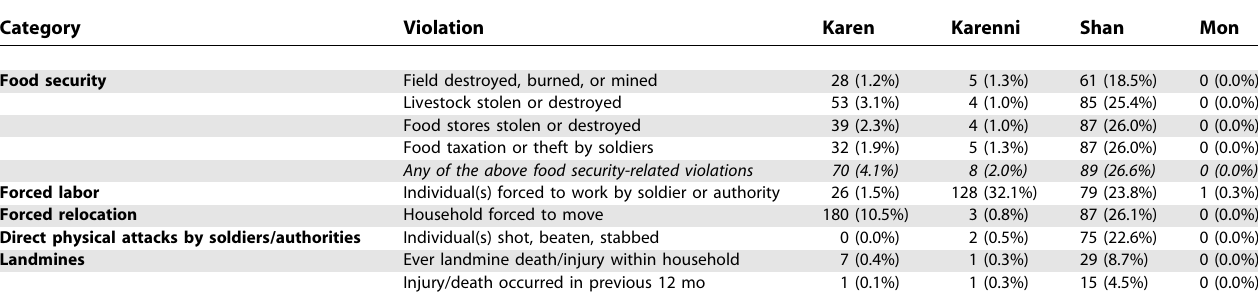
Table 3. Number and Prevalence of Human Rights Violations within the 12 Months Prior to Survey, by Area Category